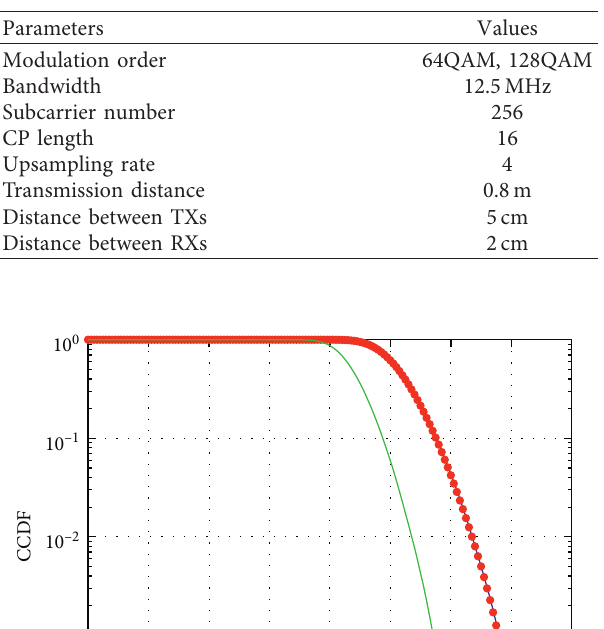
Table 1: Experiment parameters.